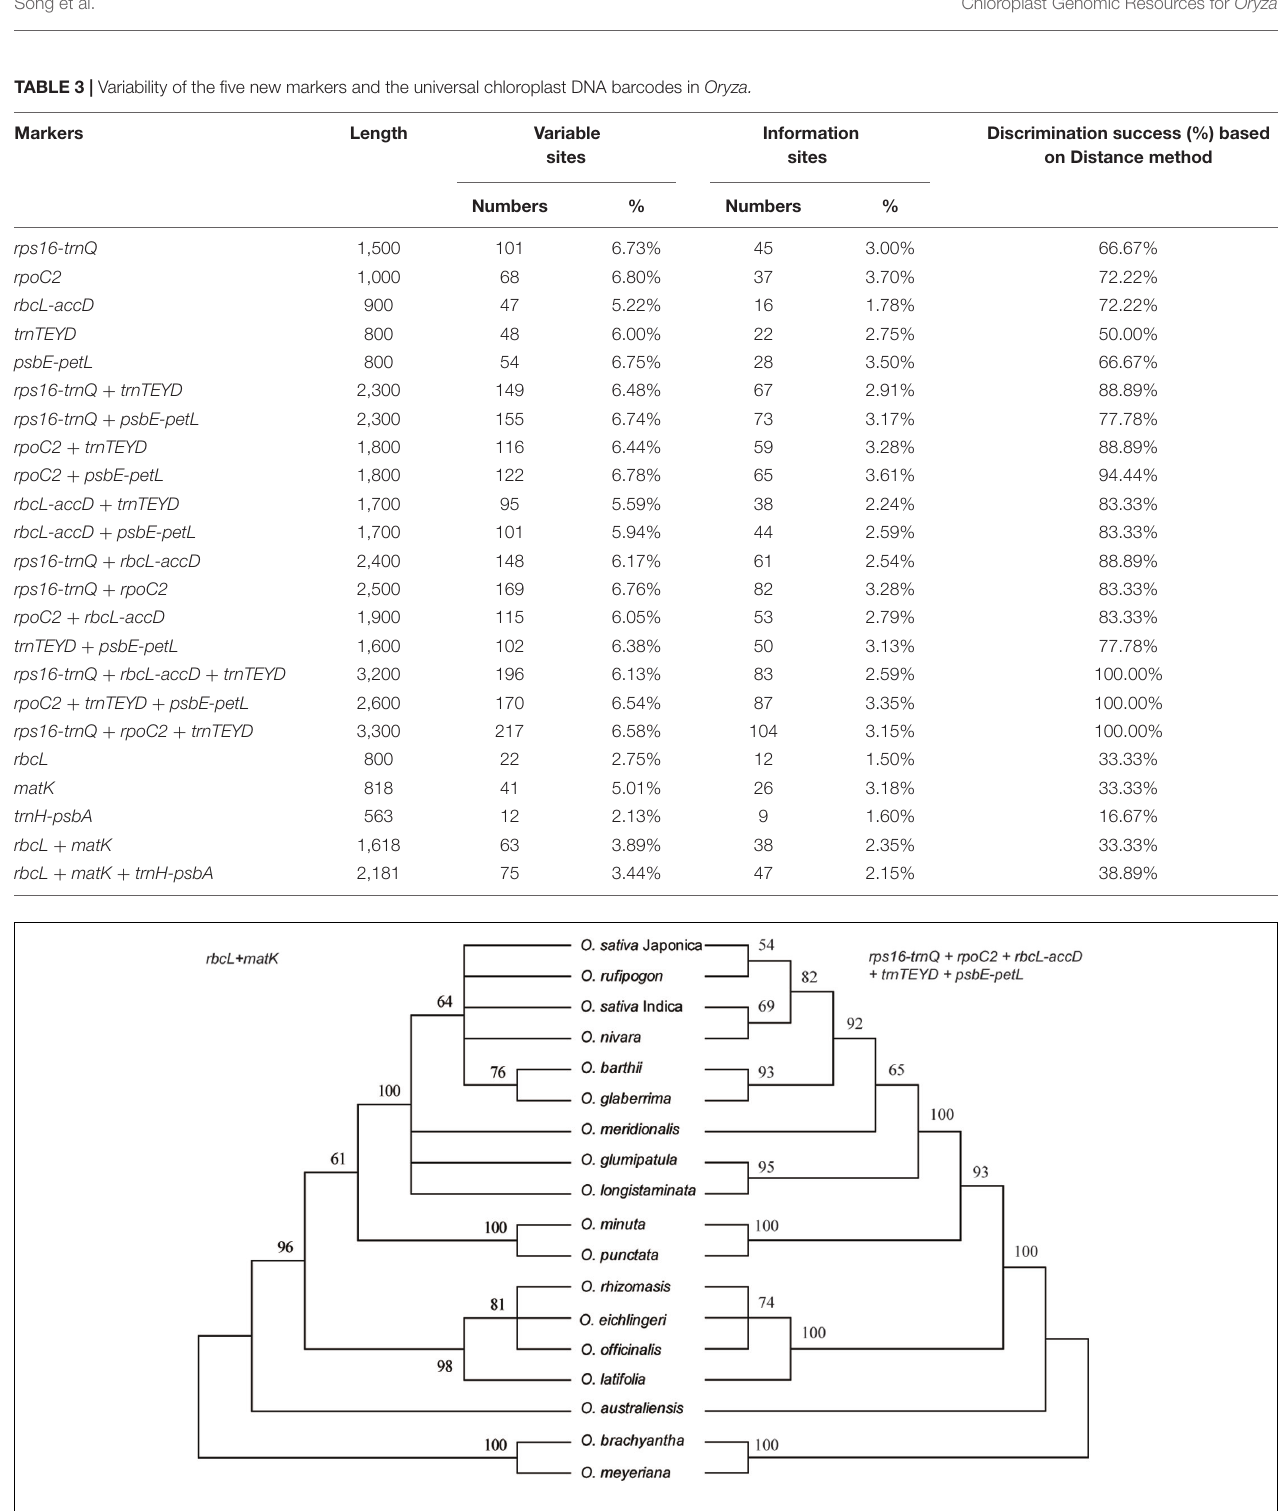
FIGURE 6 | MP tree for Oryza using the rbcL + matK and rps16-trnQ + rpoC2 + rbcL-accD + trnTEYD + psbE-petL DNA barcode combinations.